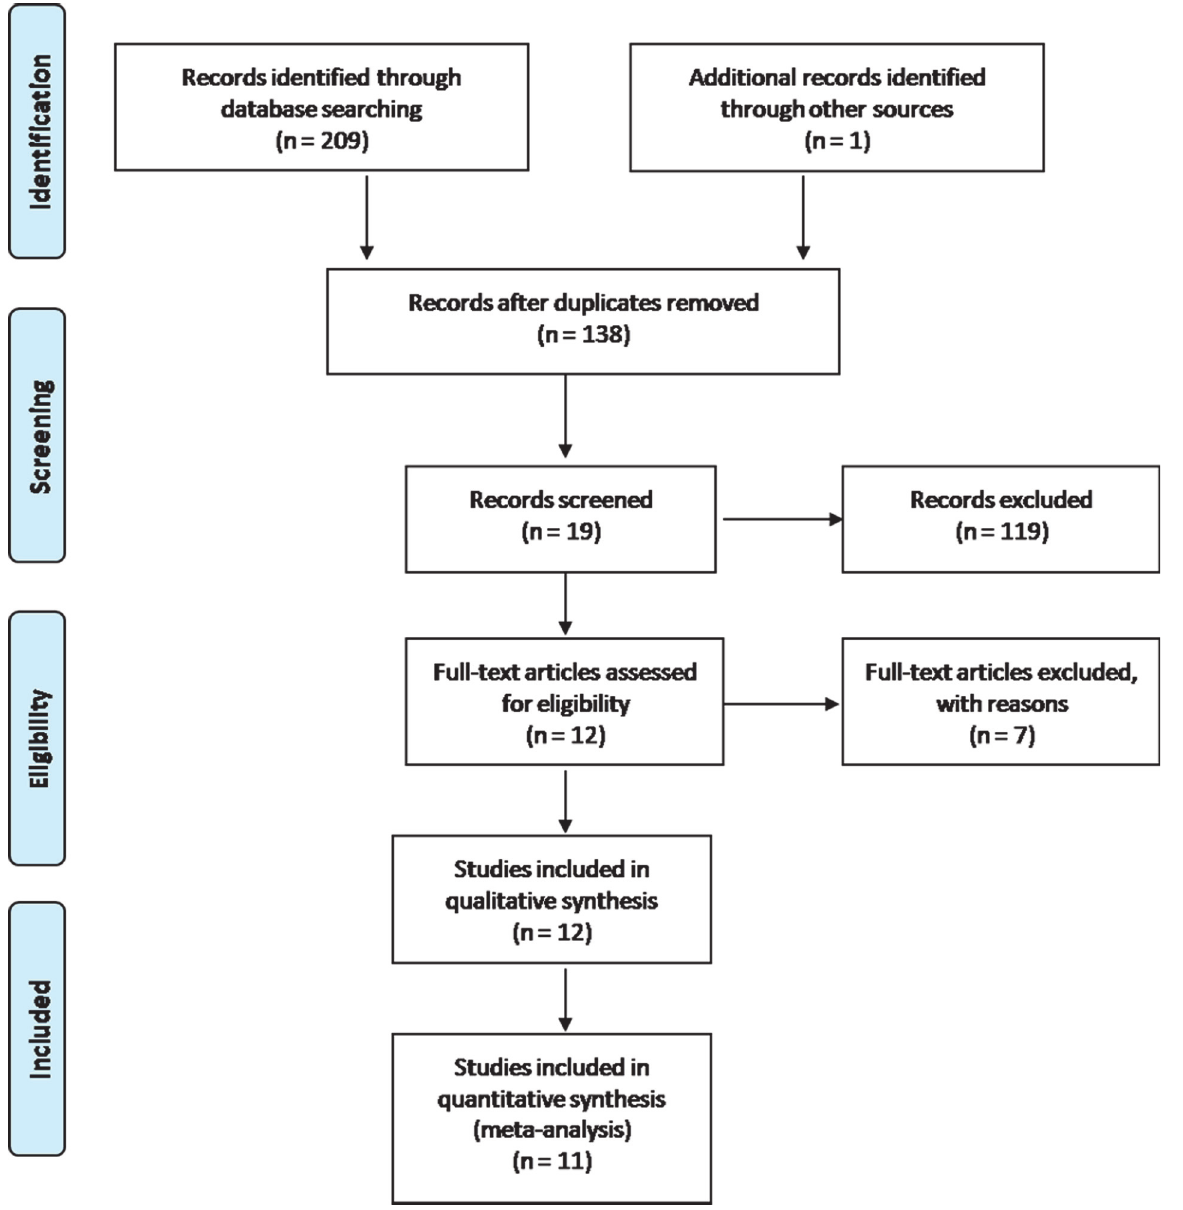
Fig 1. Flow diagram of study